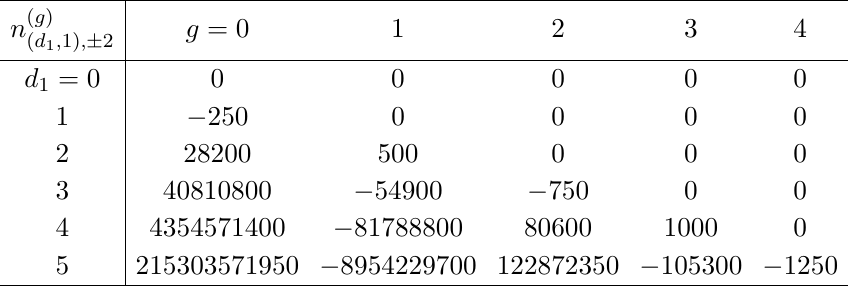
with Z charge ± 2 5 0